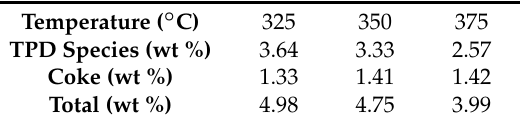
Table 1. Amounts of carbonaceous species deposited on the catalyst during the reaction determined by means of TPD and TPO